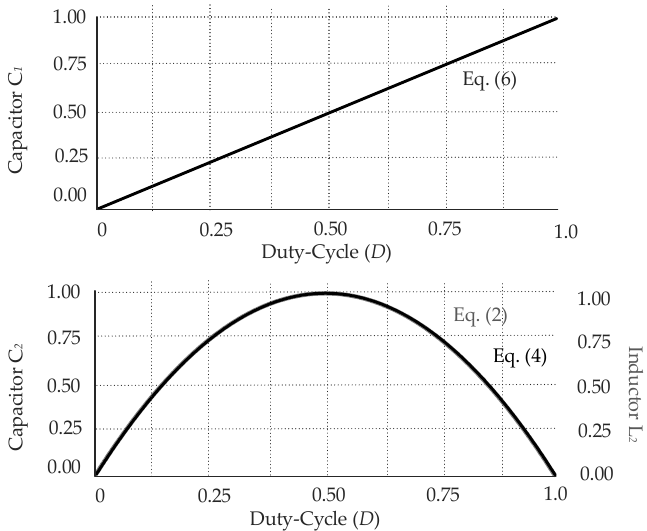
Figure 6. Duty-cycle variations for different values of n and different battery voltage levels.